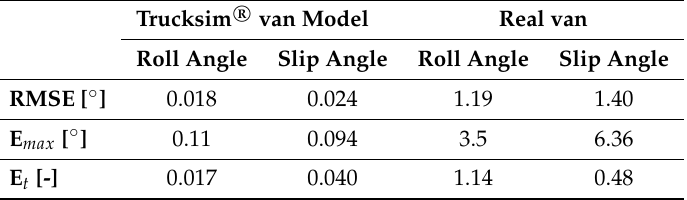
Table 3. Error measurements for validation datasets.